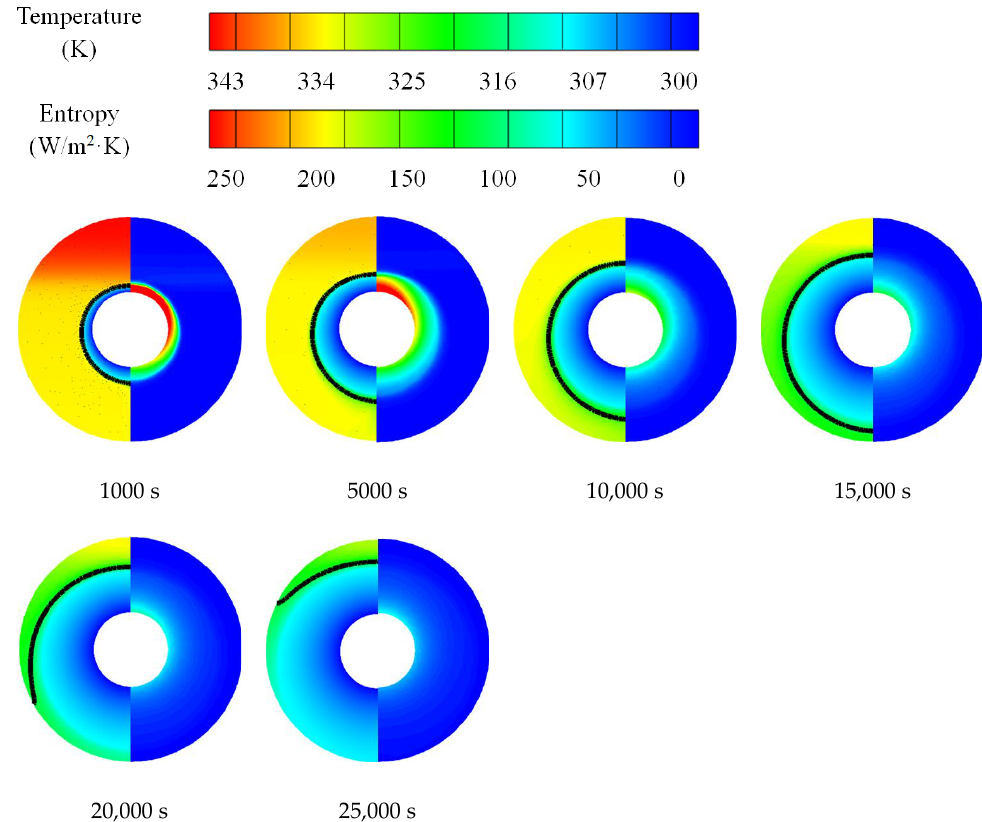
Figure 7. Temperature distribution, liquid – solid interface (left side) and local entropy generation (right side) for no-fin case in solidification.